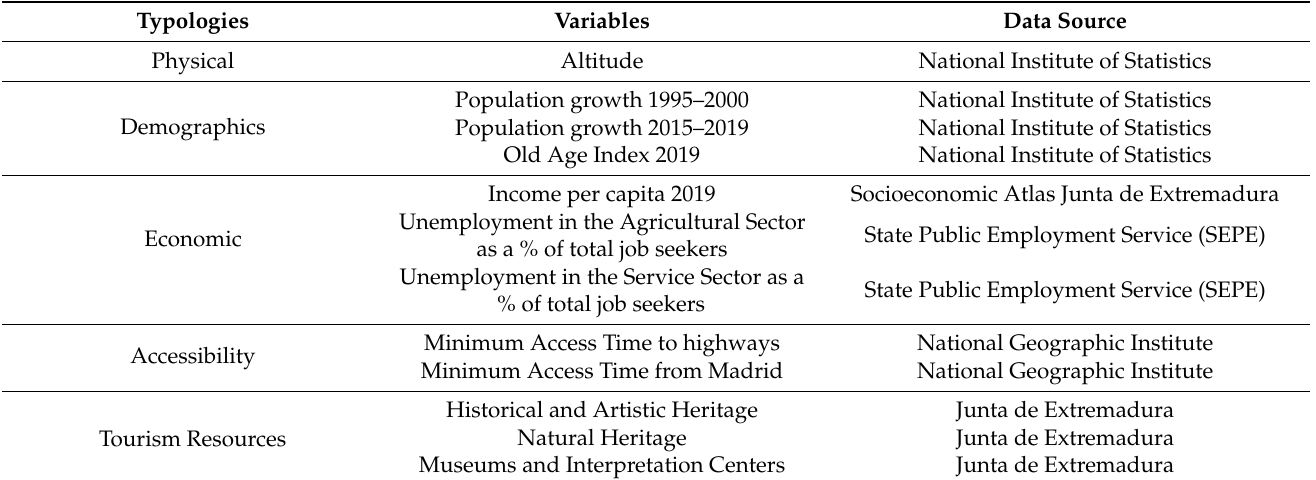
Table 1. Context